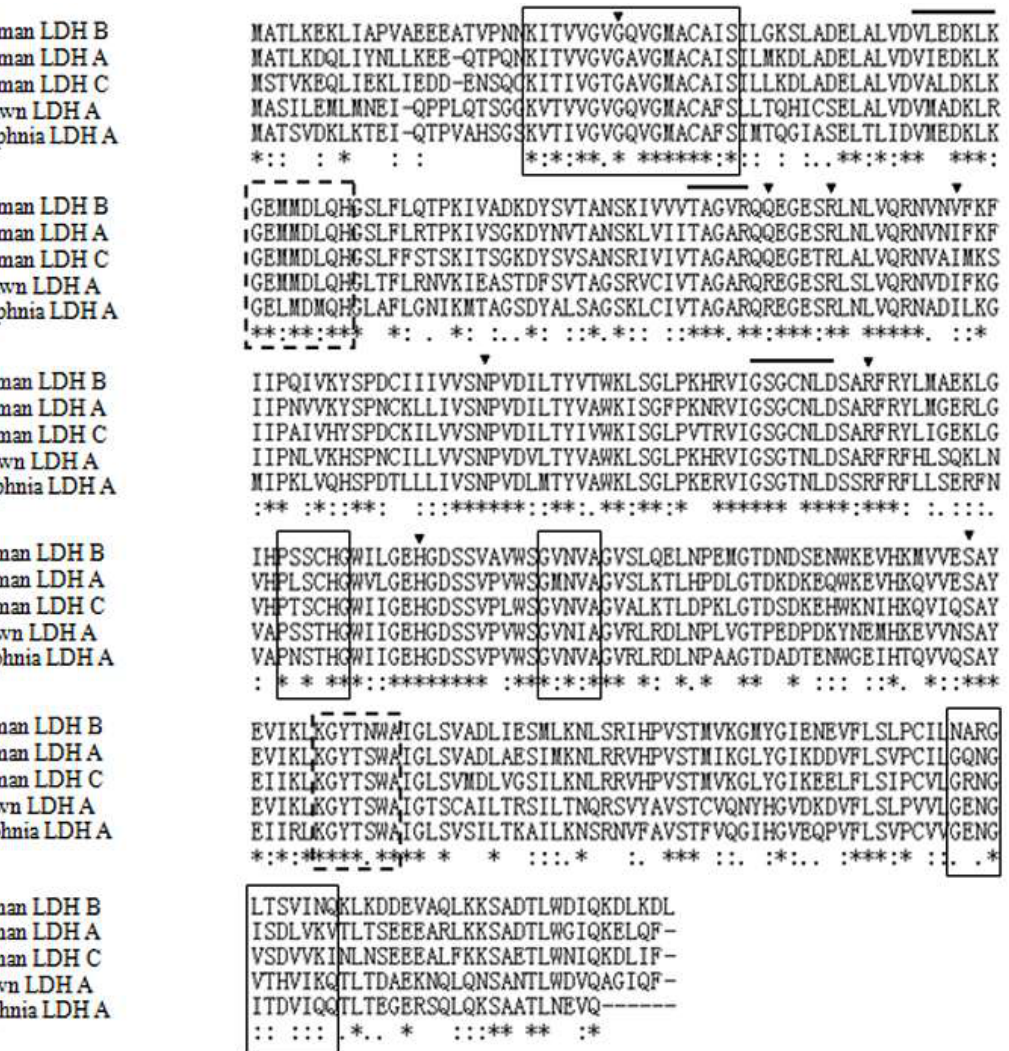
Figure 2. Multiple sequence alignment of LDH amino acid sequences. The LDHs of Macrobrachium nipponense (Prawn LDH), Daphnia pulex (Daphnia LDH-A) and Homo sapiens (Human LDH-A, -B and -C) sequences are included in the analysis. (*) identical residues; (:) conservative substitutions; and (.) semi-conservative substitutions. The residues involved in the binding sites for substrate and NAD + , and the dimer and tetramer interfaces, are marked in triangle and with a line above, a dashed box and a black solid box, respectively.